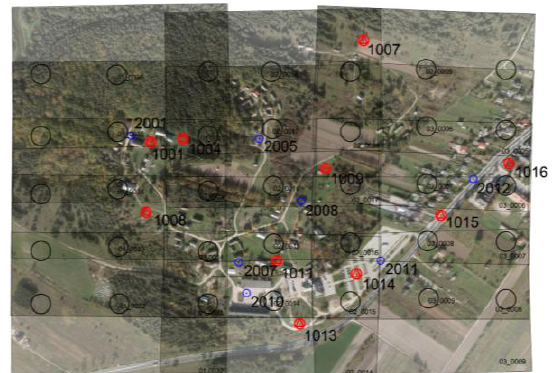
Figure 6. Digital images taken from a classical photogrammetry aircraft (only 15 images). Red circles denote "GCP" and blue points denote "check points". Black points represent "tie- points".